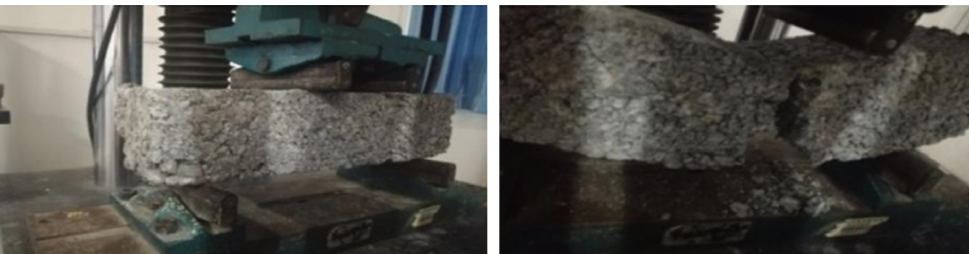
Figure 12: Specimen before and after test.